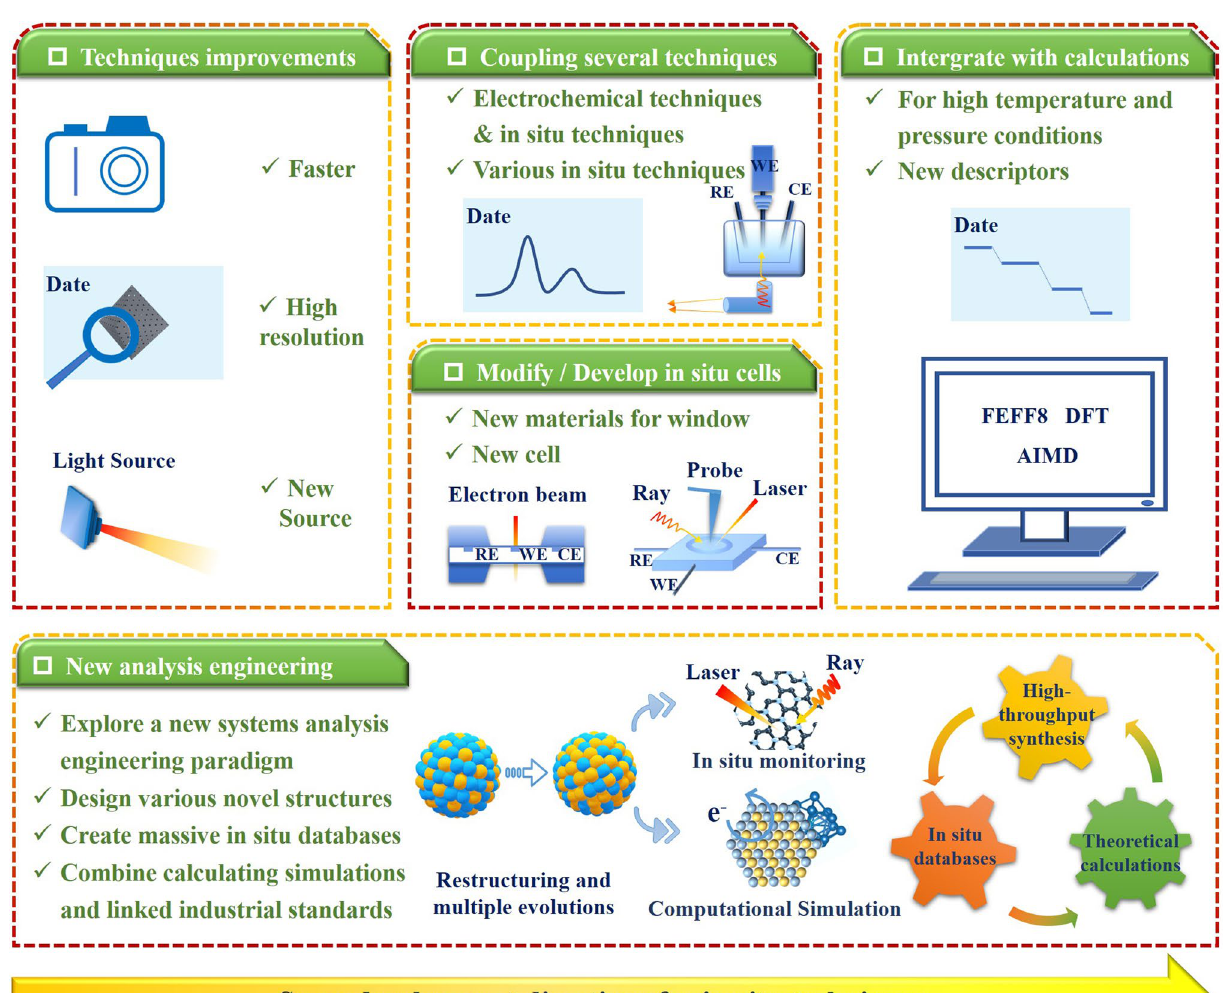
Fig. 17 Summary of some development directions for in-situ techniques on questing ORR